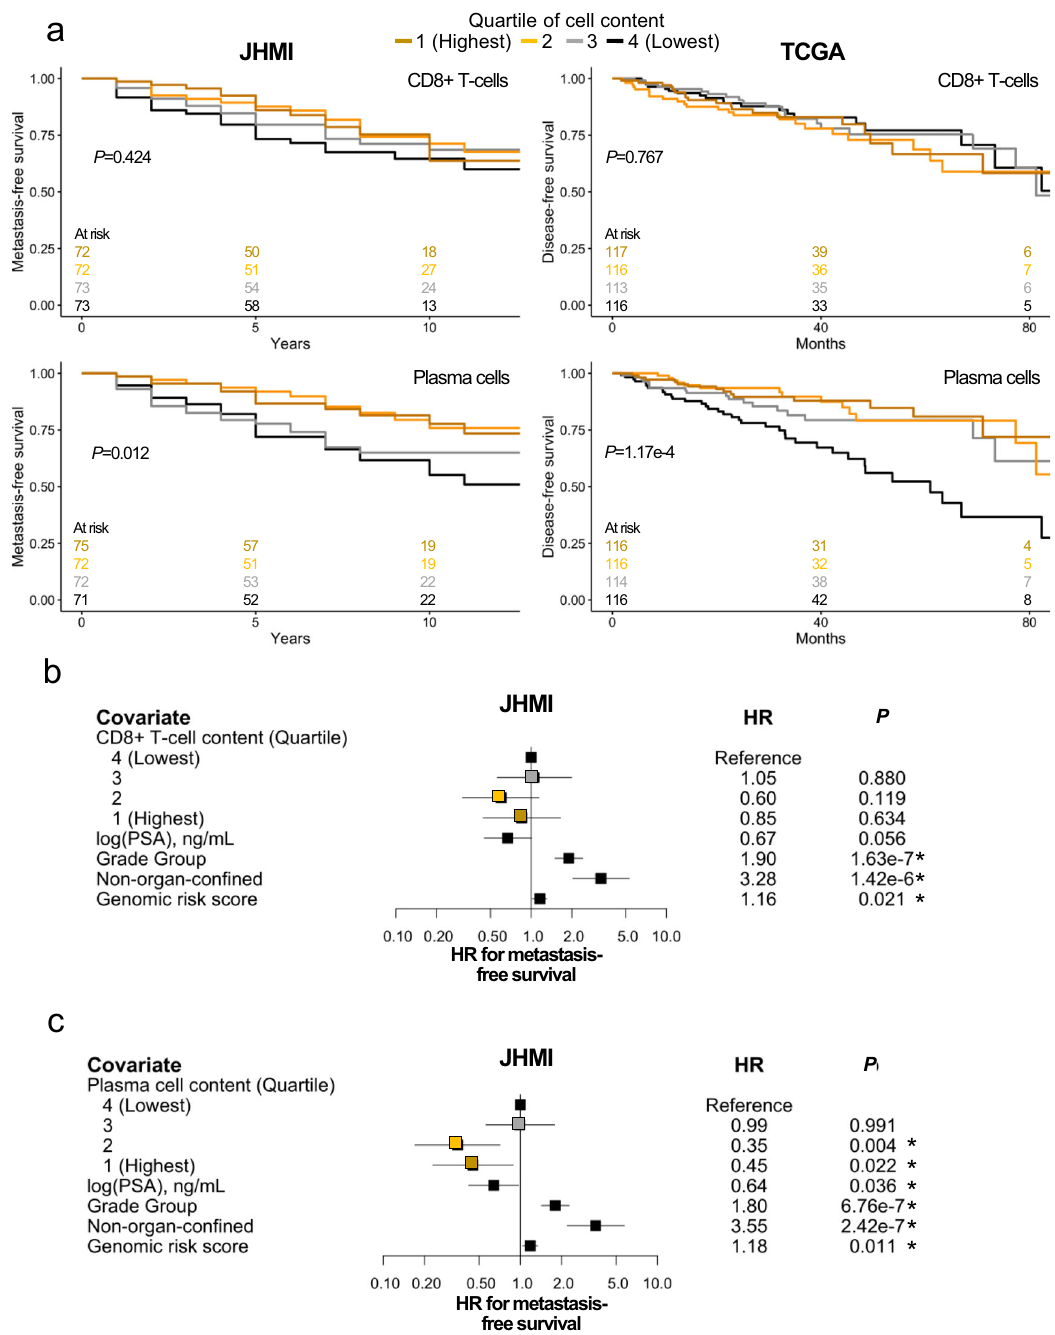
Fig. 3 High intratumoral plasma cell content is associated with improved outcomes. Increasing plasma cell content is associated with longer disease-free survival while increasing CD8 + T-cell content is not ( a ) (log-rank two-sided P -values) even after adjusting for clinical covariates in Cox regressions ( b – c ) ( n = 300 patients; HR ± 95% con fi dence interval; two-sided P -values). Asterisks indicate statistical signi fi cance with p < 0.05. Abbreviations: JHMI